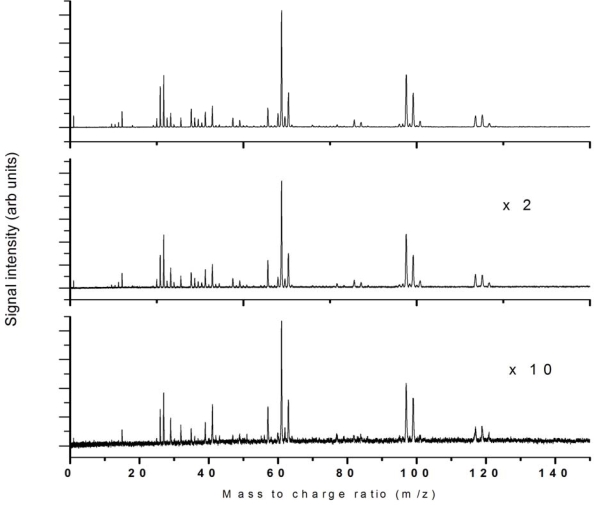
397 nm ionization using 7.6 × 1013 W/cm2, 4.9 × 1013 W/cm2 and 3.1 × 1013 W/cm2.